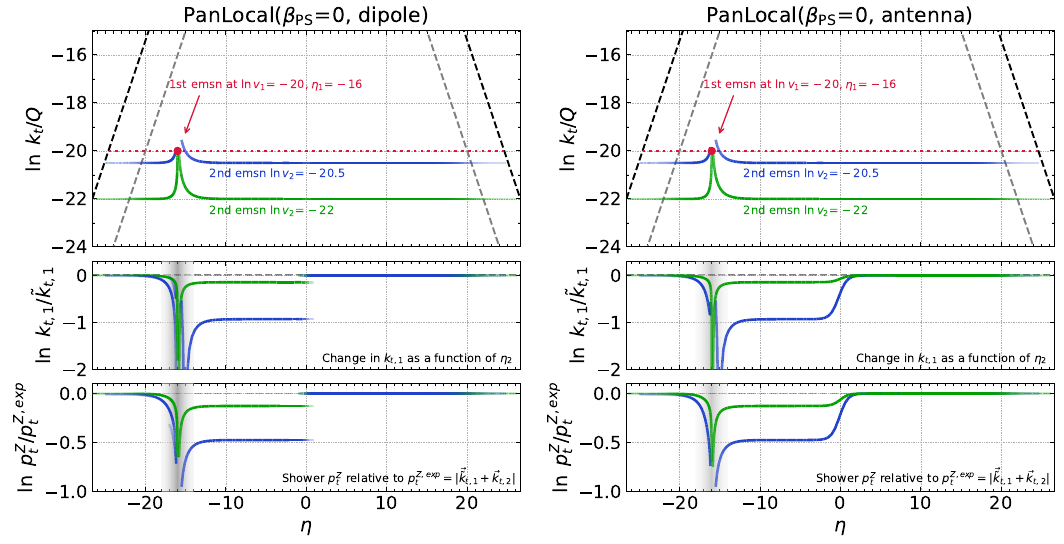
Figure 7. Same as figure 2, but for PanLocal, dipole (left) and antenna (right) with β ps = 0